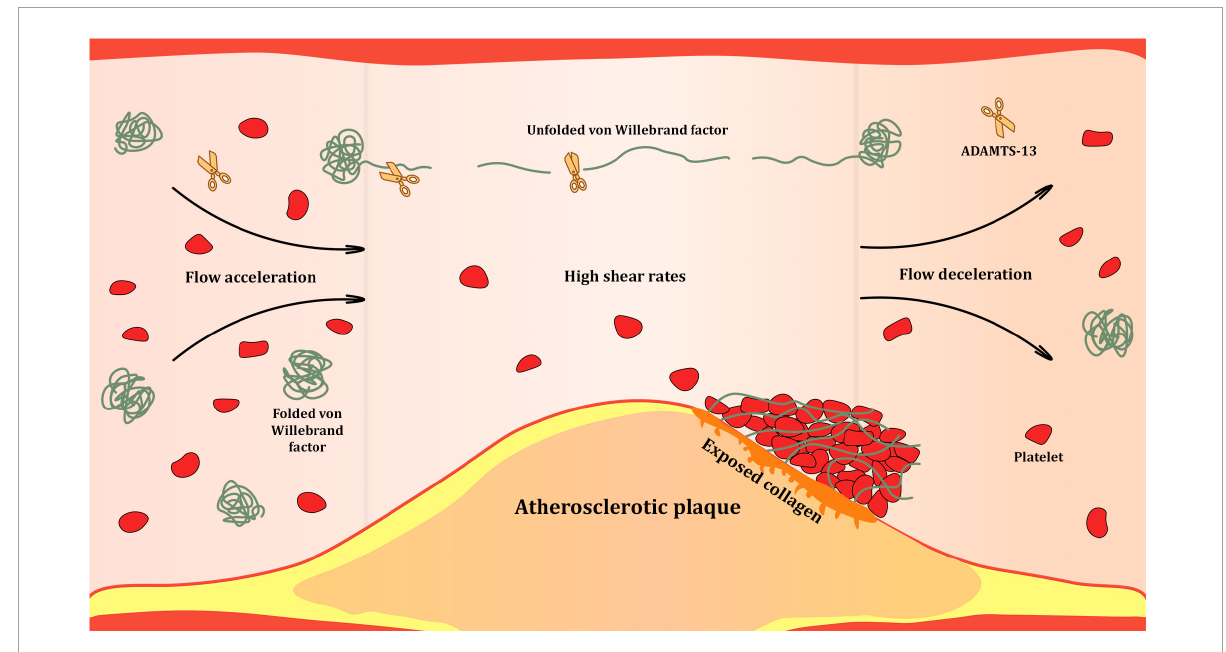
FIGURE3 Shear-rate dependent activation of Von Willebrand factor (VWF) at the site of atherosclerotic stenosis. High shear rates occurring in the bloodstream at sites of significant atherosclerotic narrowing of the arterial lumen trigger unfolding of VWF multimers. Unfolded VWF presents a range of binding sites for proteins of subendothelial matrix, platelets and leukocytes. It is also subjected to proteolysis by ADAMTS-13 that cleaves unfolded VWF multimers at the A2 domains and reduces their hemostatic